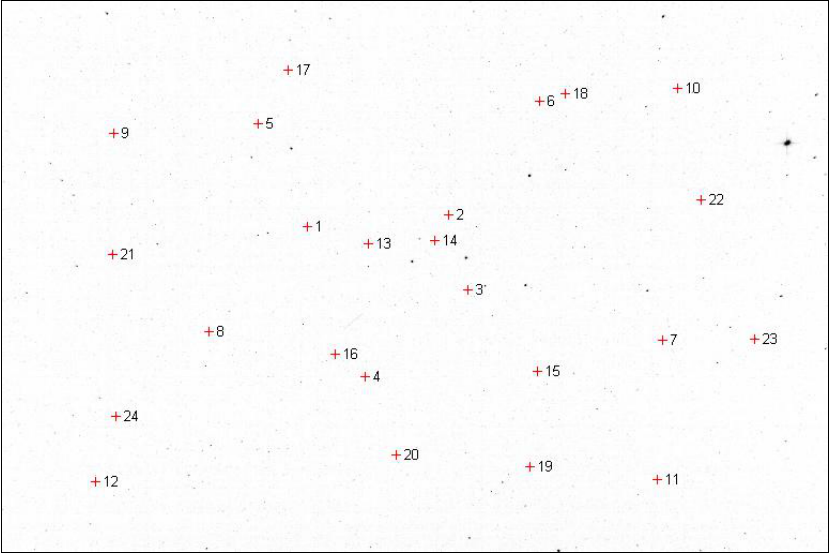
Figure 2. Reference stars used for internal calibration-position on the Marisel